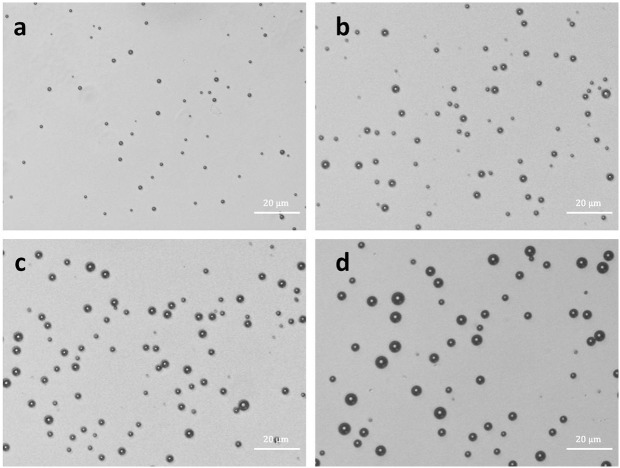
Bright-field images of (a) SNB 1, SNB 2 (b), SNB 3 (c) and control MBs (d), revealing spherical appearance and good dispersity (bar = 20 μm).